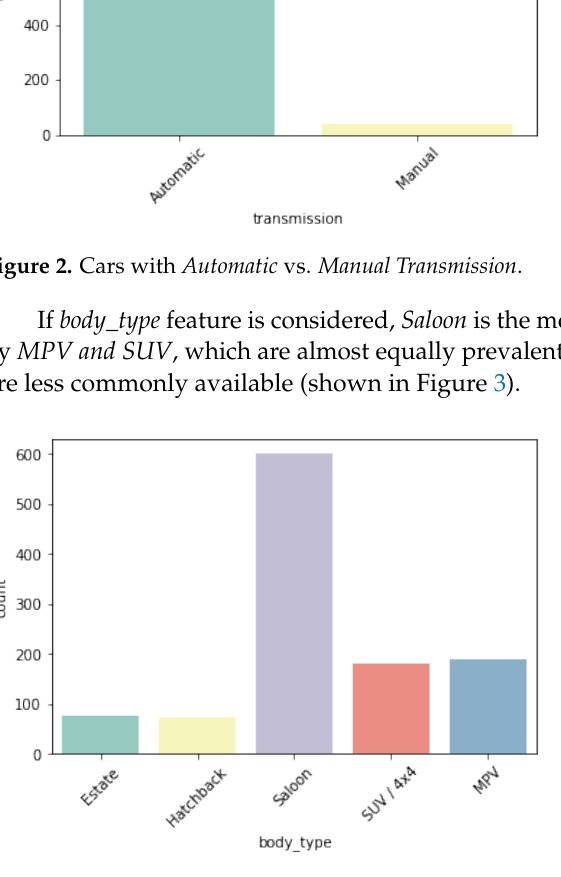
Figure 3. Number of cars with different body_type feature.